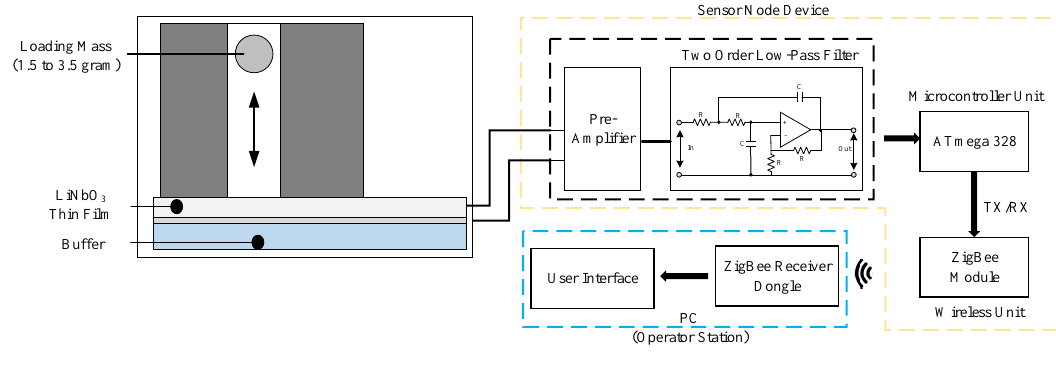
Figure 3. SN architecture.